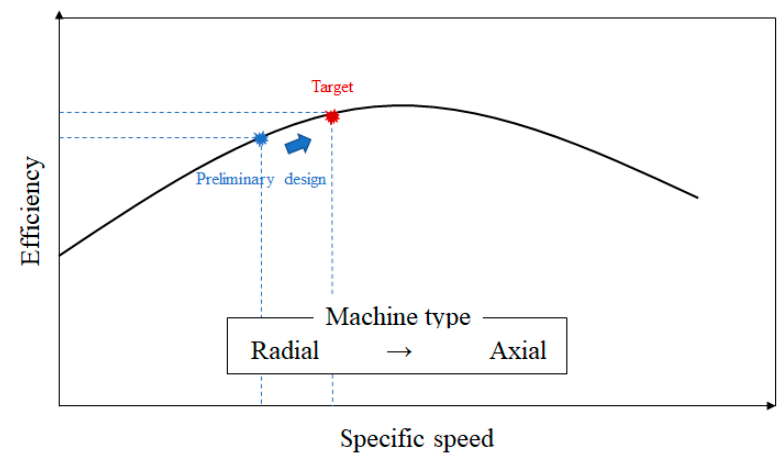
Figure 1. Geometry of the two-vane pump. Processes 2020 , 8 , x FOR PEER REVIEW